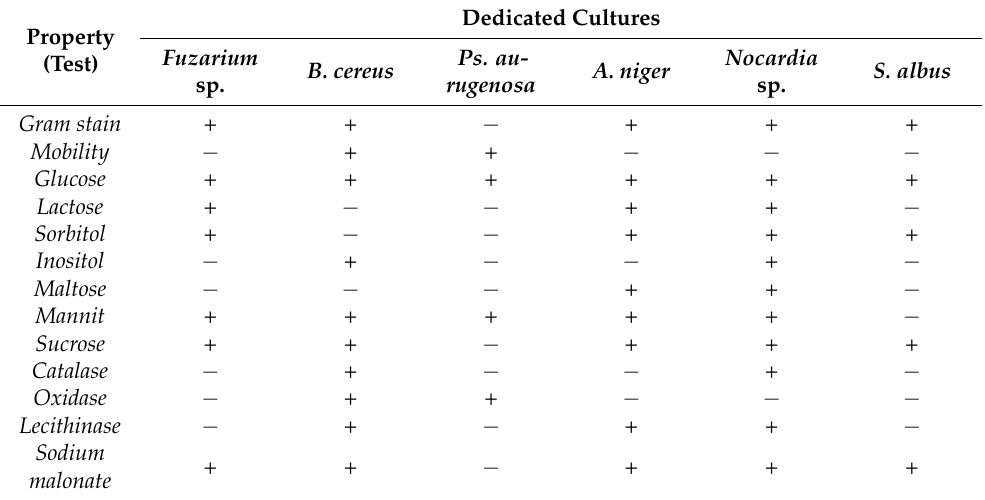
Table 4. Studied properties of isolated microorganisms (+ positive test, − negative test, (+) weakly positive